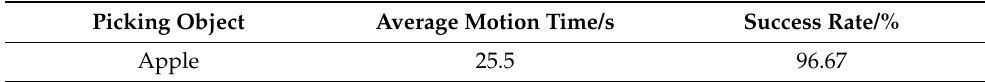
Table 9. The results of harvesting tests.